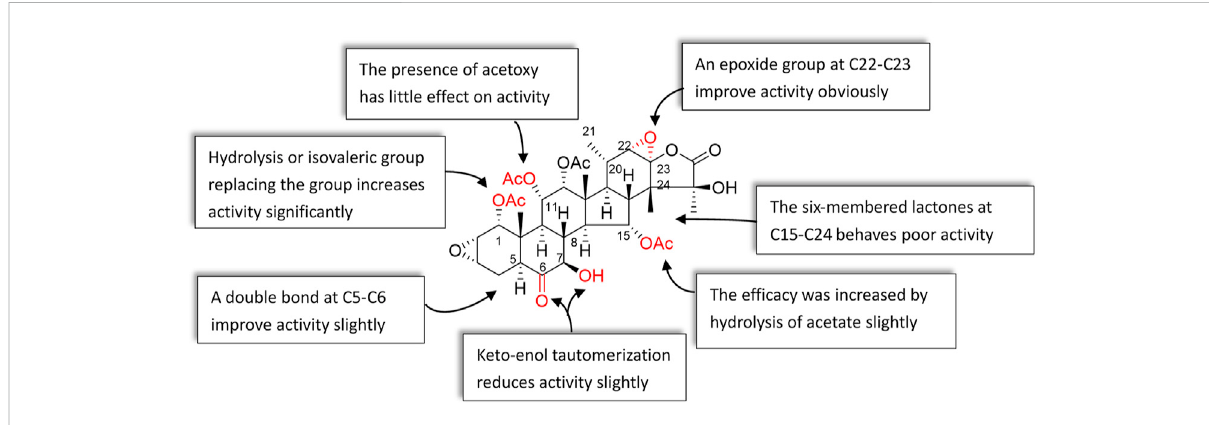
FIGURE 7 Structure and antiproliferative activity relationship of